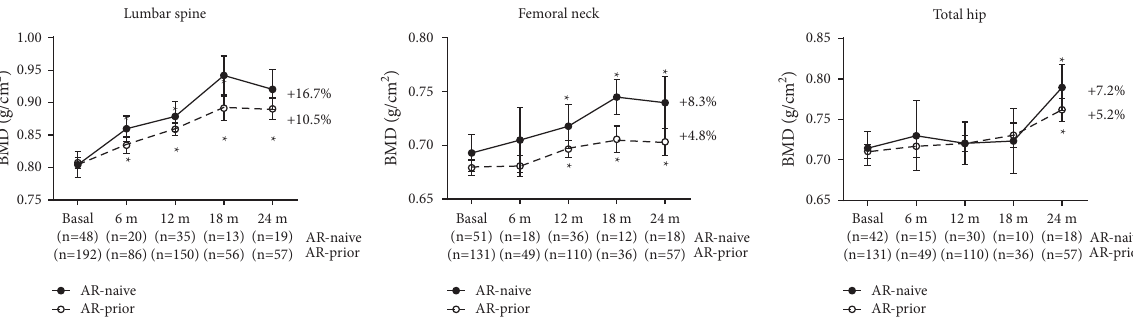
Figure 3: Changes in BMD in antiresorptive (AR)-na¨ıve vs. AR-prior patients. Wilcoxon signed-rank test. Mean ± SEM. ∗ Indicates signifcant diferences vs.